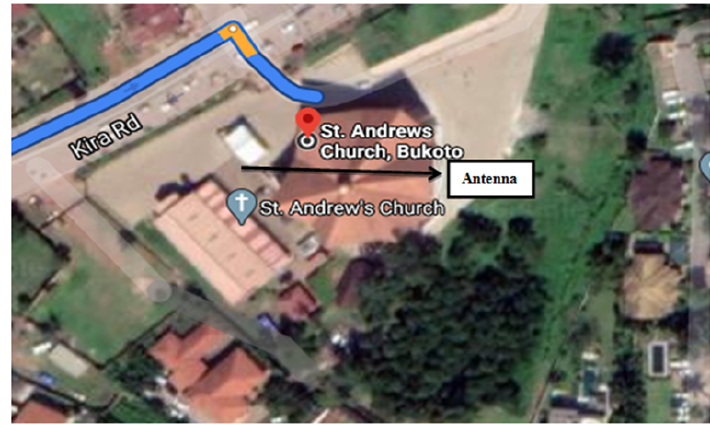
Figure 1. One of the measurement